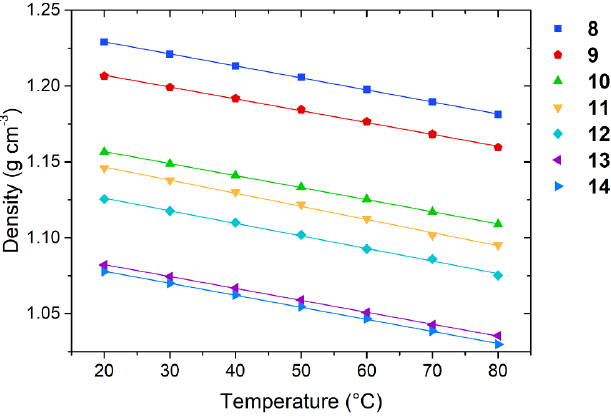
Figure 2. Densities of ILs 8 – 14 in a temperature range from 20 to 80 °C.